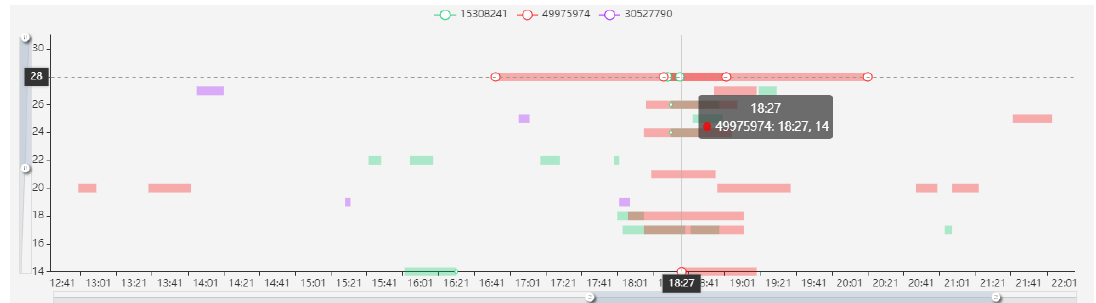
Figure 4. Passenger travel time pixel matrix view supports interactive exploration.